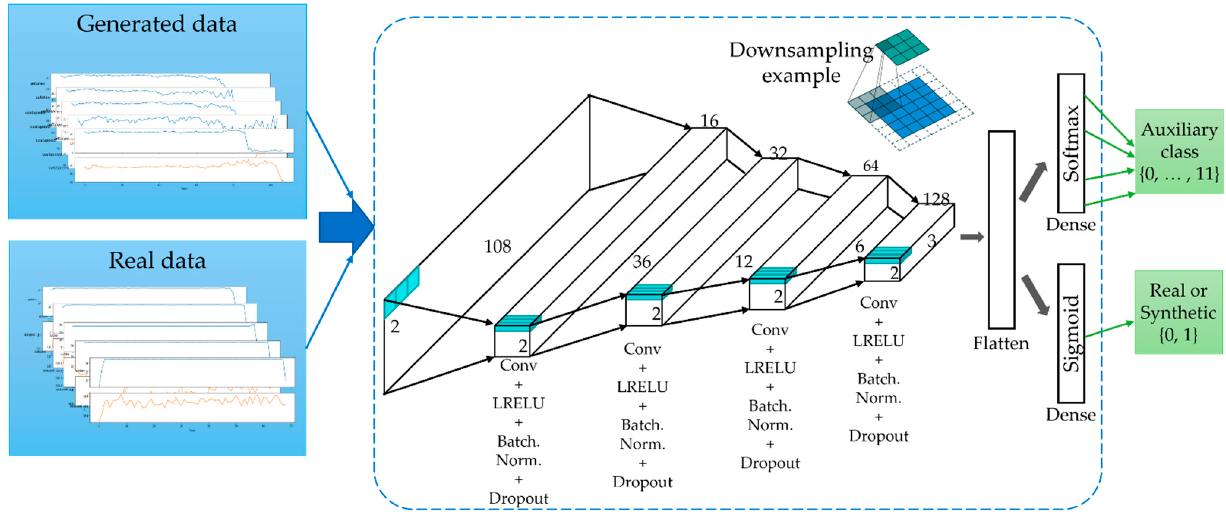
Figure A4. Implementation details of the generator model for the casting process.